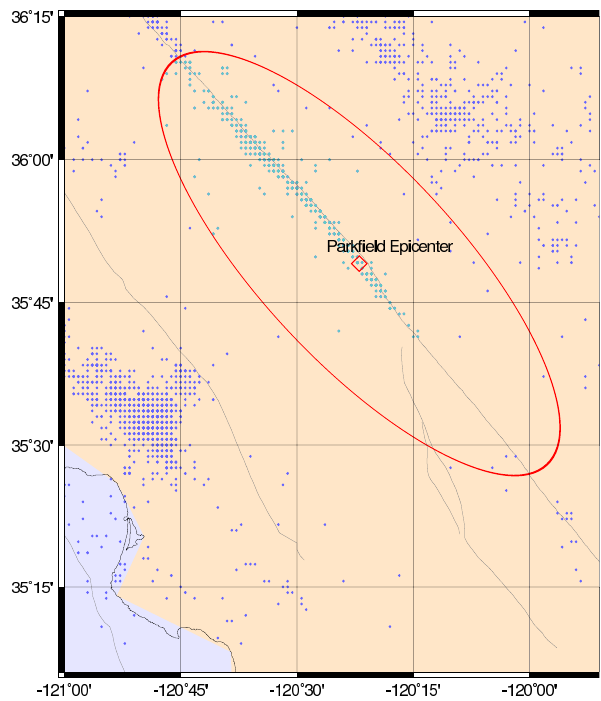
Fig. 3. Earthquakes included in the Parkfield aftershock catalogue are enclosed by the red ellipse and events occurred after the 28 September 2004 mainshock ( M W = 5 . 96); epicenter 35.818 ◦ N, − 120 . 366 ◦ W, inclined 50 ◦ south of east (Shcherbakov et al.,